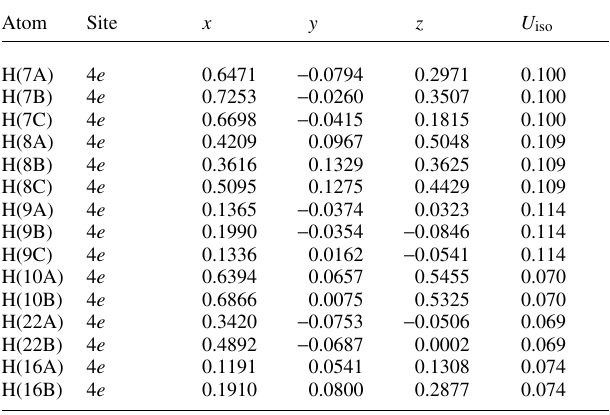
Table 2. Atomic coordinates and displacement parameters (in Å 2 )